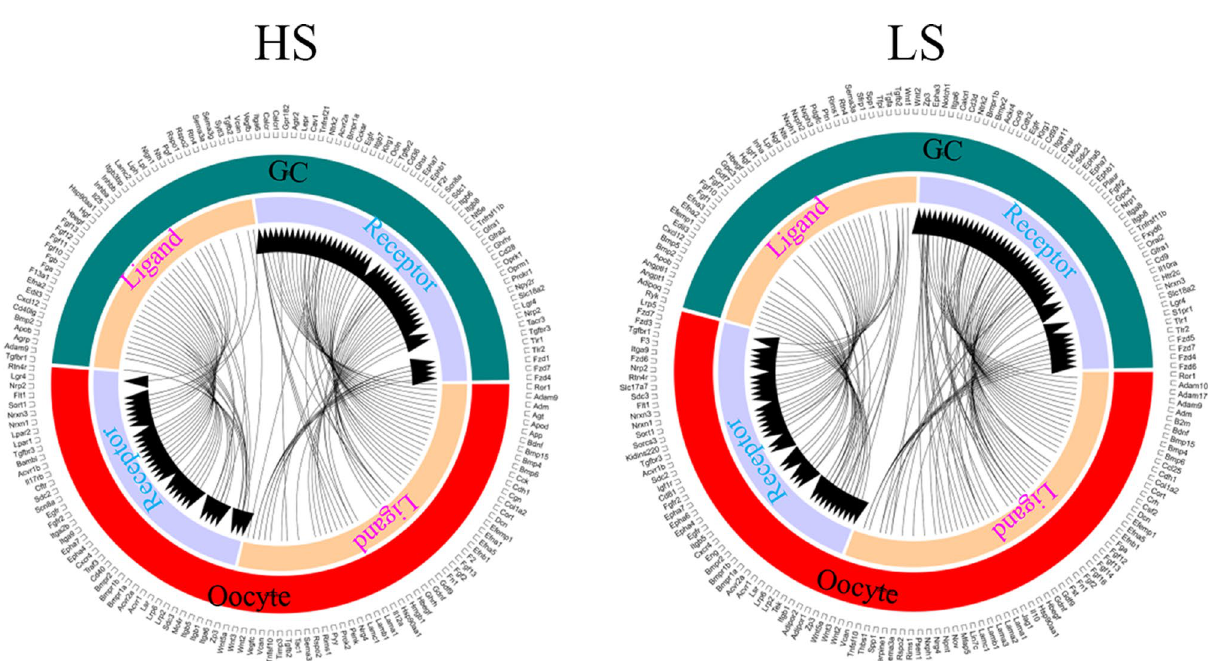
Figure 8. Ligand–receptor pairs, and ligand and receptor encoding genes expressed in high fertility and low fertility groups oocyte and GCs of goat small follicles. Outside circle showed in GC or oocyte; while inside circle showed ligands or receptors. Free R package Circlize (version0.4.11; https:// cran.r- proje ct. org/ web/ packa ges/ circl ize/) software was